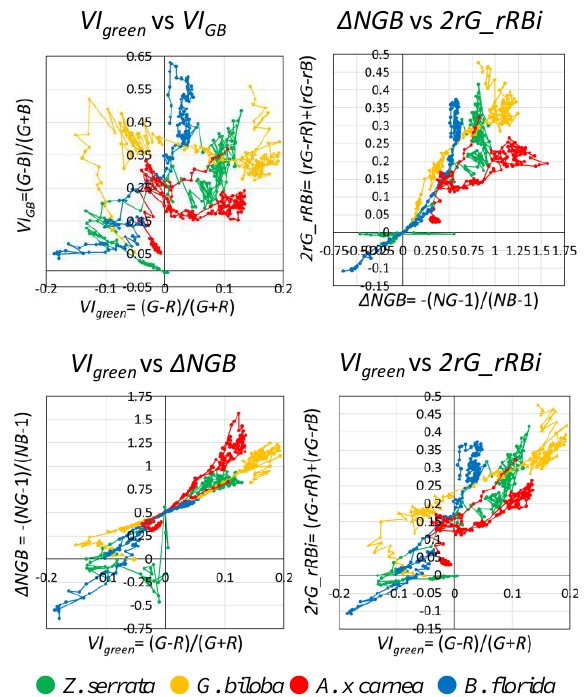
Figure 6. Time series changes of 4 trees on each coordinate in 4 feature spaces of two indices.